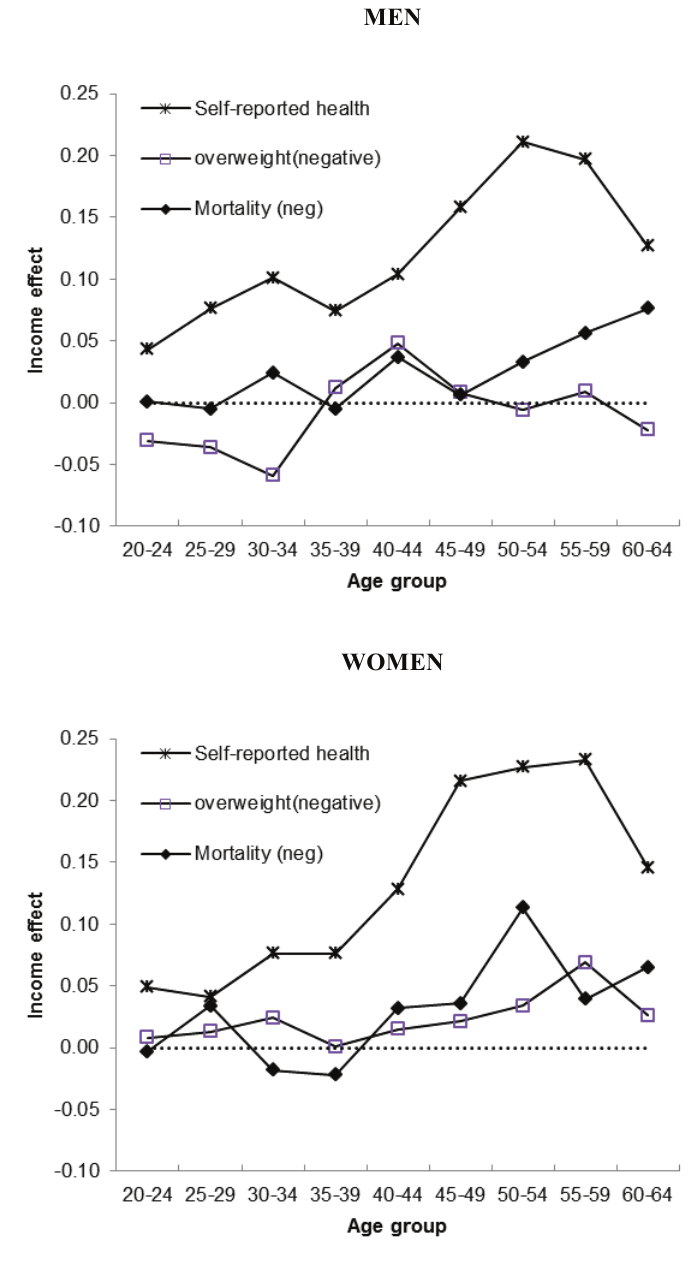
Fig. 1-2 Age variation in the relationship between income and health. Notes: The size of the income effect is on the y-axis and the x-axis describes the age groups. The income effects for the age groups are estimated in a pooled OLS model (see equation